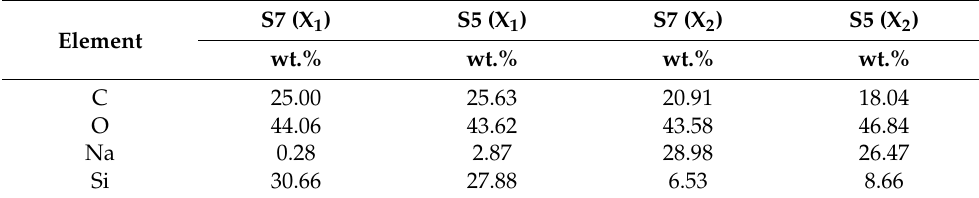
Table 11. EDX result of samples S7 and S5 measured at points X 1 and X 2 after fire-retardant test.